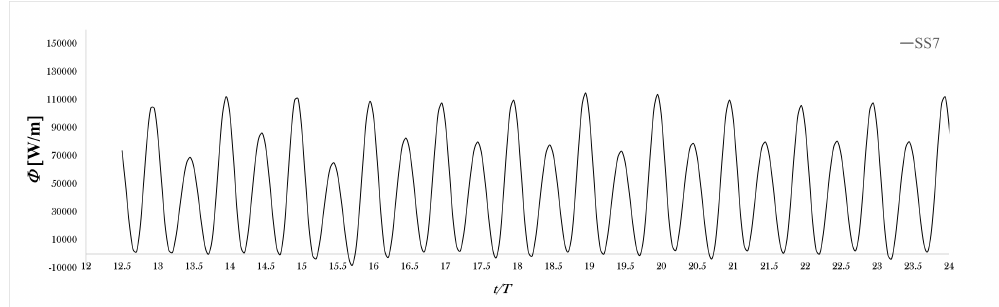
Figure 10. Instantaneous energy flux in the middle ( BB (cid:48) ) of the flume ( H = 2.5 m, T = 8 s).